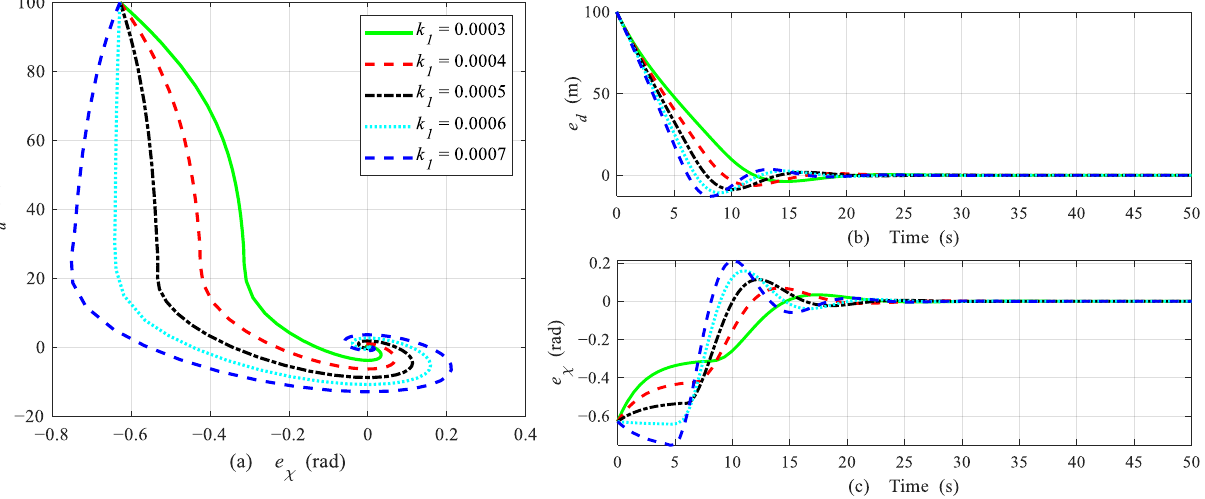
Figure 3. The dynamics of the nonlinear system (9) with ‖∇𝑓‖ = 1 , 𝑉 = 25⁡m/s , and 𝑘 2 = 0.0008 , but under five different values of 𝑘 1 . ( a ) The phase plots of the system (9); ( b ) the trajectories of 𝑒 𝑑 with respect to time; ( c ) the trajectories of 𝑒 𝜒 with respect to time.